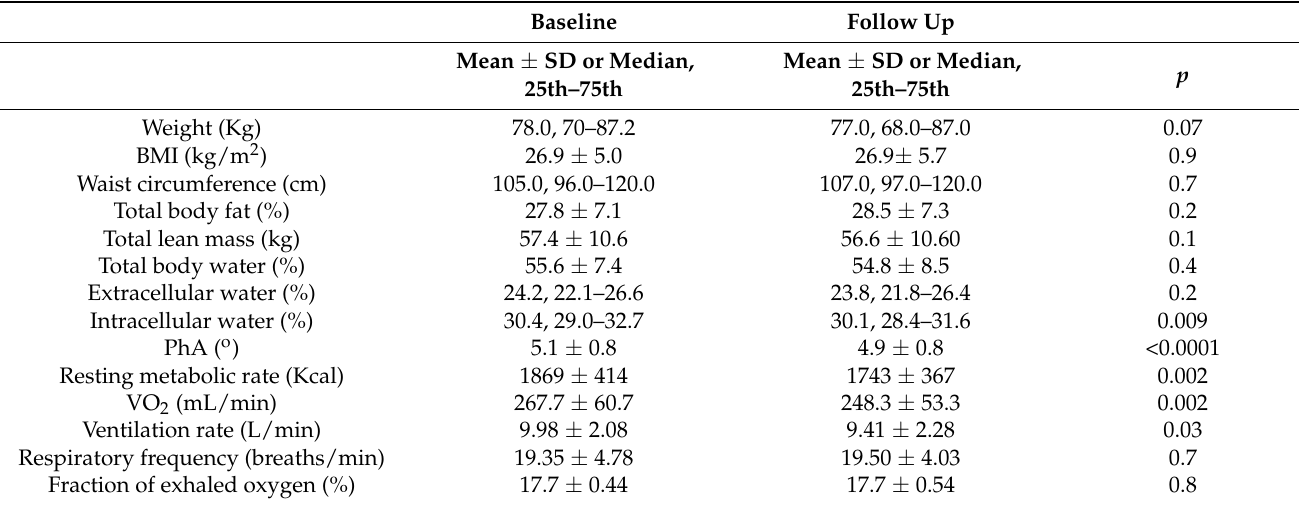
Table 2. Changes in body composition and resting metabolic rate after treatment in all patients( n = 82).